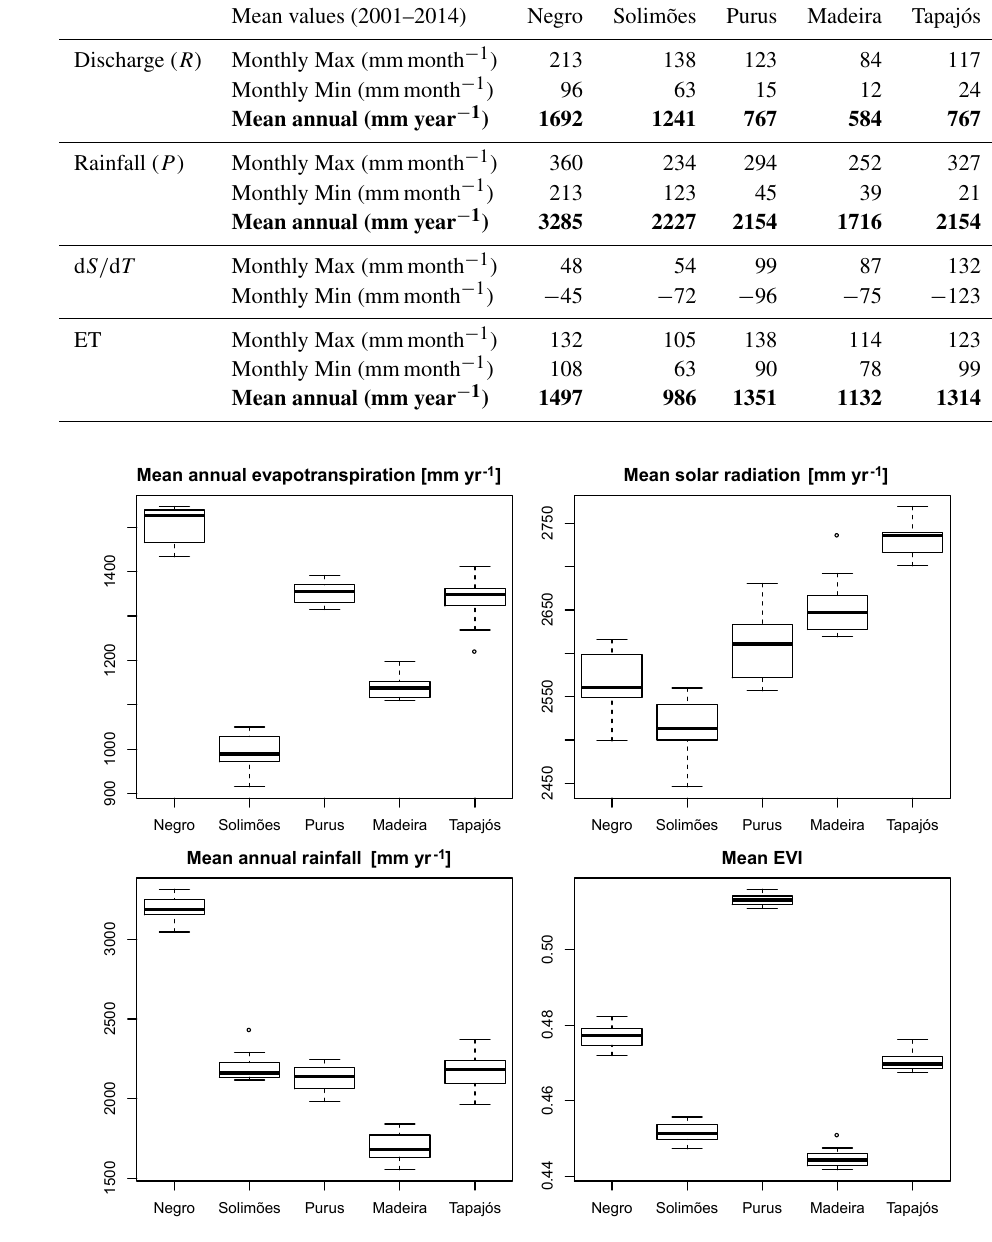
Figure 2. Boxplots with mean annual evapotranspiration, solar radiation, rainfall and EVI for the five sub-basins analysed in the study for the period 2001–2014